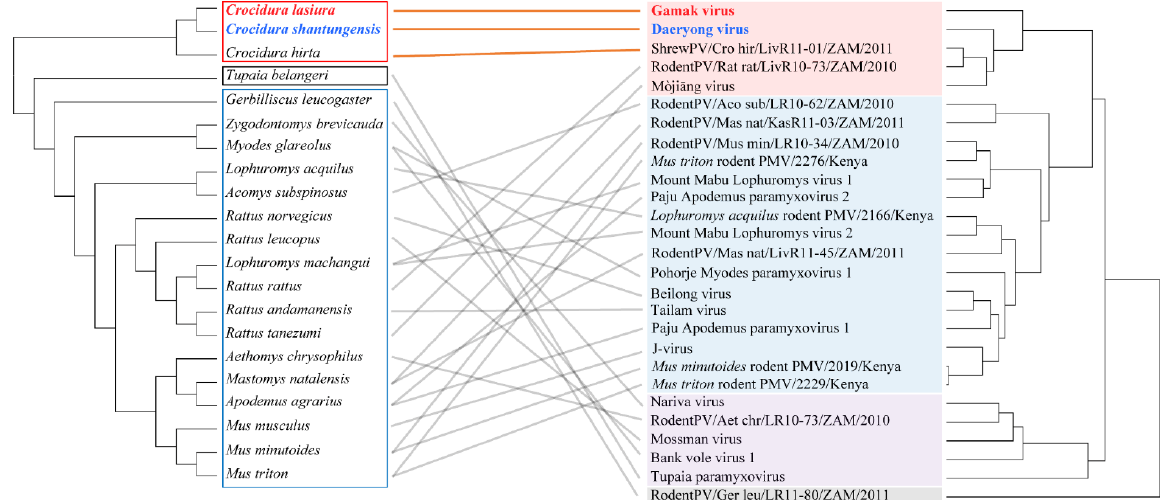
Figure 5. Tanglegram comparing the phylogenies between paramyxoviruses and their reservoir hosts (insectivores and rodents). The tanglegram was generated using the R package, using Bayesian consensus tree, based on the nucleotide sequences of the paramyxoviral L gene (right panel) and cytochrome b gene of mitochondrial DNA sequences of the host species (left panel). Letters for taxa are indicated in red for Crocidura lasiura in the left panel and Gamak virus in the right panel, respectively. Letters for taxa are shown in blue for Crocidura shantungensis in the left panel and Daeryong virus in the right panel, respectively. The left panel shows shrew species in the red box, rodent species in the blue box, and mole species in the black box. The right panel shows genus Henipavirus in the red box, genus Jeilongvirus in the blue box, genus Narmovirus in the purple box, and outgroup in the grey box.